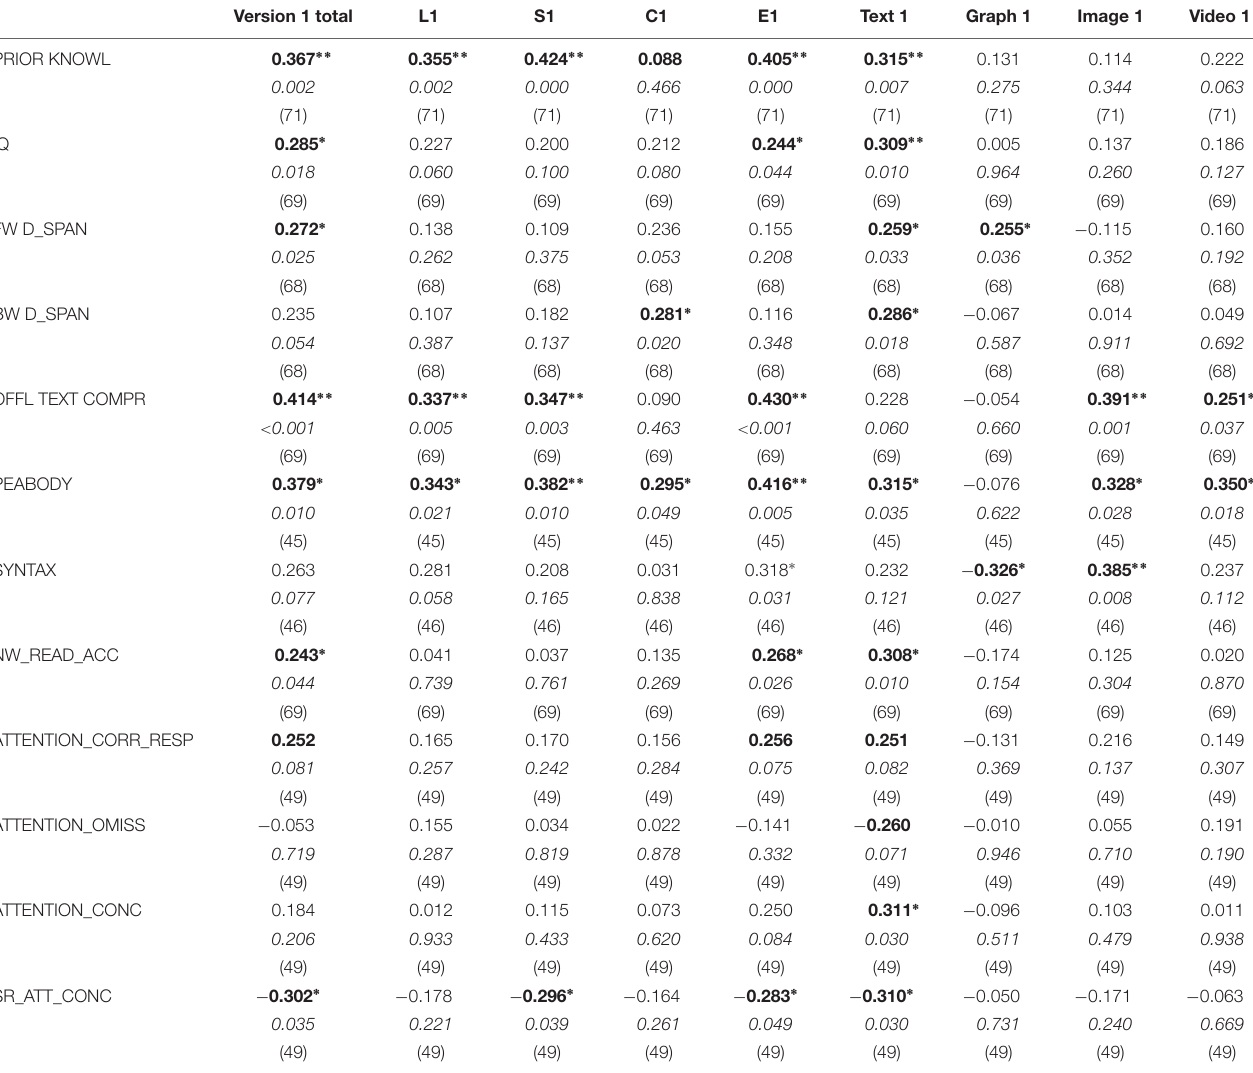
TABLE 1 | Pearson correlations between ORCA.IT variables and prior knowledge (digital competence and familiarity with topics), IQ, language skills (vocabulary and syntactic abilities), attentional variables (expressed by both objective and self-reported measures concerning organization capacity, attentional shifting and focusing, sustained attention, concentration, self-management, and emotional control), reading (words and non-words, speed, and accuracy), and memory measures (forward and backward digit